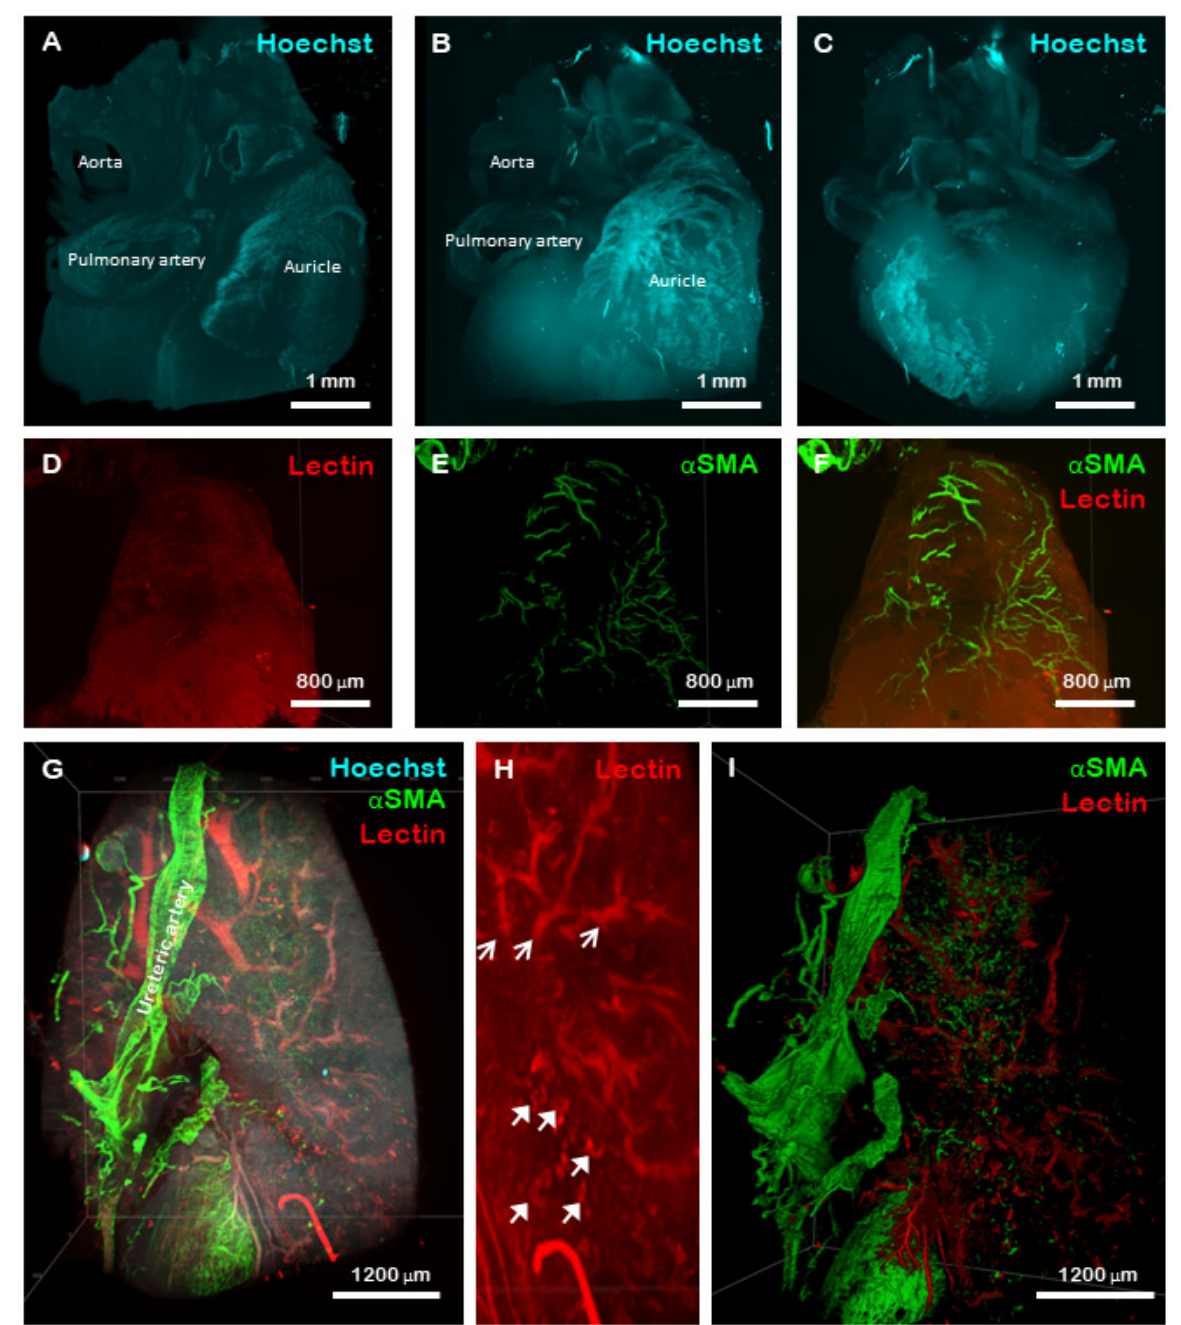
Figure 4. LSFM of CUBIC cleared mouse heart and kidney. A volumetric representation of a mouse heart following staining with Hoechst 33324 nuclear stain demonstrating various anatomical features is shown in ( A ). The same portion of heart tissue as a maximum intensity projection displaying the same anatomical features is shown in ( B , C ). Mouse auricle stained with lectin (red) and α SMA (green) showing the blood supply of the tissue is shown in ( D – F ). Mouse kidneys were also stained with Hoechst 33342 (blue), α SMA (green) and lectin (red) ( G ), and clearly demonstrate the ureteric artery on the outside of the capsule. When stained with lectin, individual Loops of Henle were visible within the cortex of the kidney ( H closed arrows ) together with acuate arteries and venules ( H open arrows ). A volumetric representation of the vasculature of the murine kidney stained with lectin (red) and α SMA (green) is shown in ( I ).